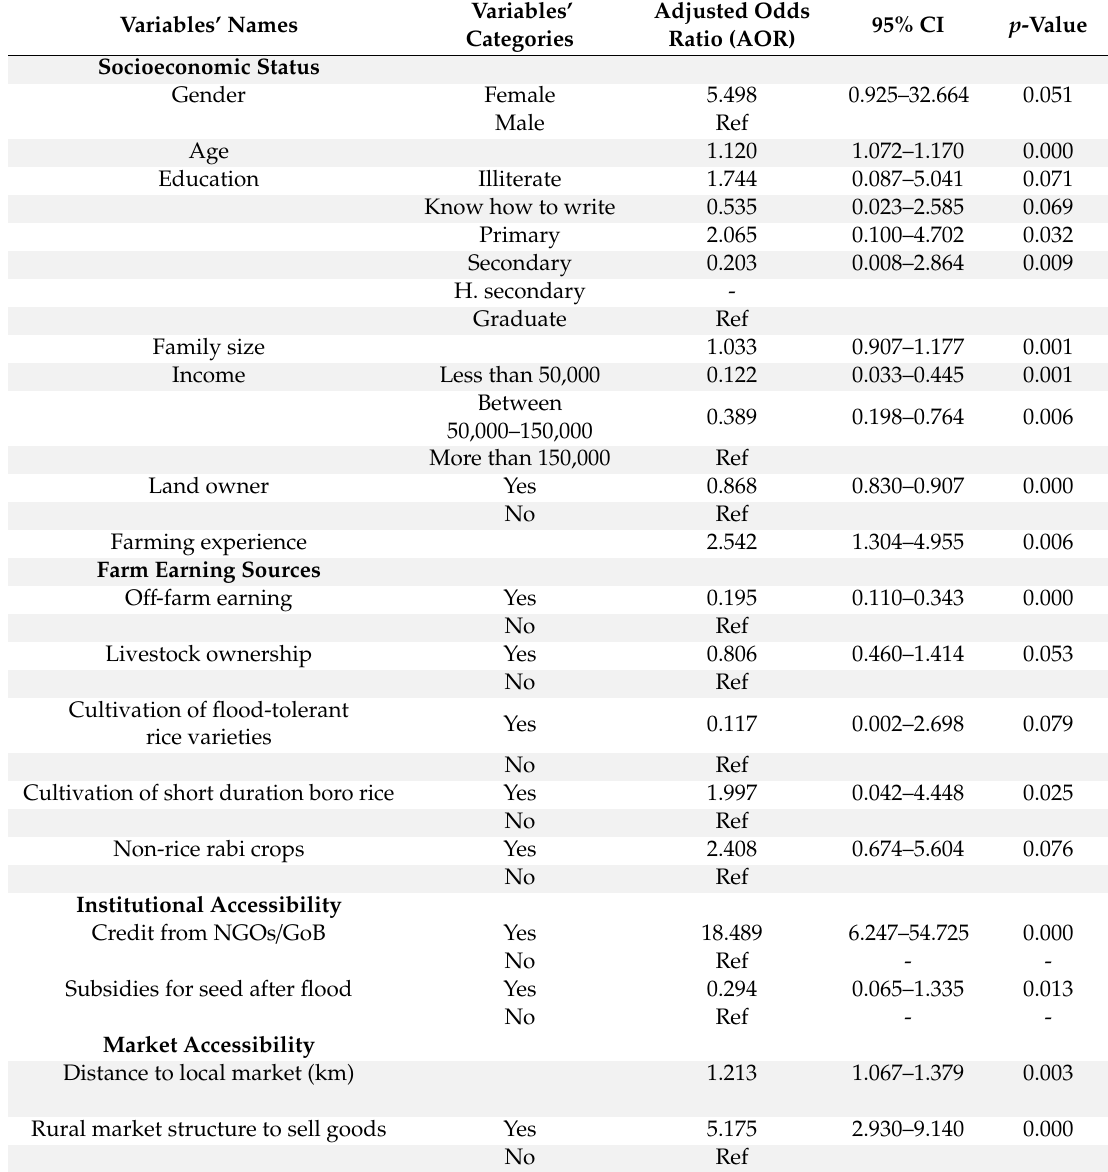
Table 4. Factors a ff ecting farmers’ adaptation practices. Here, the dependent variable is the presence of flood-related adaptation